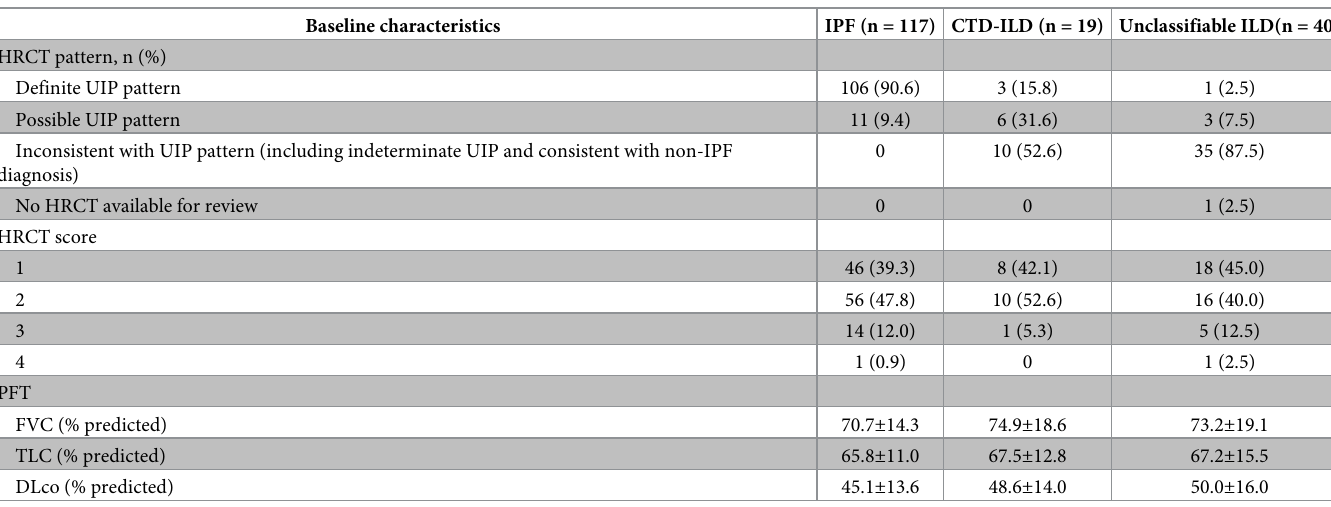
Table 2. Baseline HRCT and PFTs.